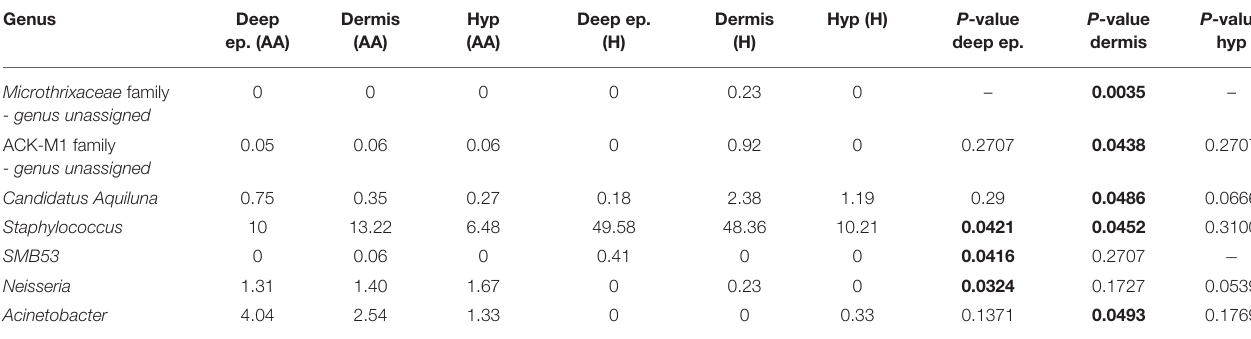
TABLE 1 | Statistically significant differences in genera relative abundances between AA and healthy subjects (H) in deep epidermis (Deep ep.), dermis and hypodermis (Hyp). Genus Deep